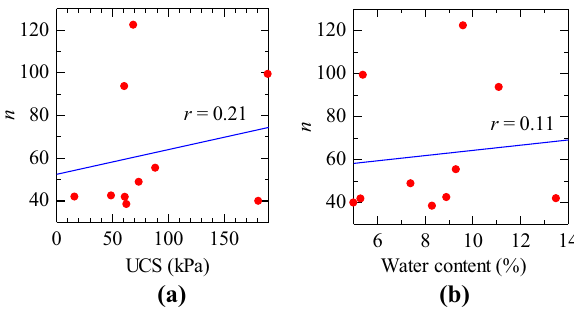
Fig. 10 Relationship between n and ( a ) UCS (d ε /d t = 10 − 5 (s − 1)) or (b) b ater content